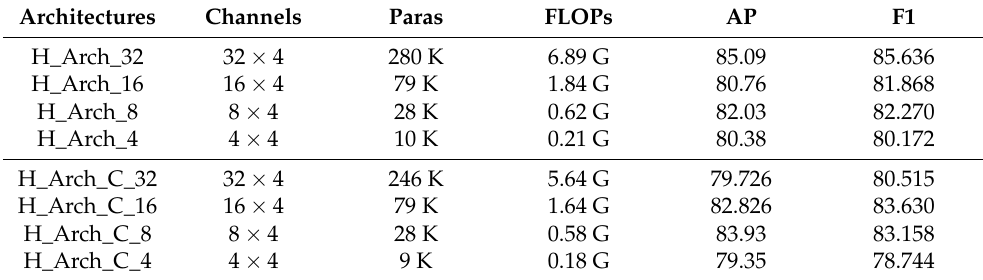
Table 5. Detection results on HRSID (the first four are obtained by setting ops _ ratio = 0, and the last four are obtained by setting ops _ ratio =